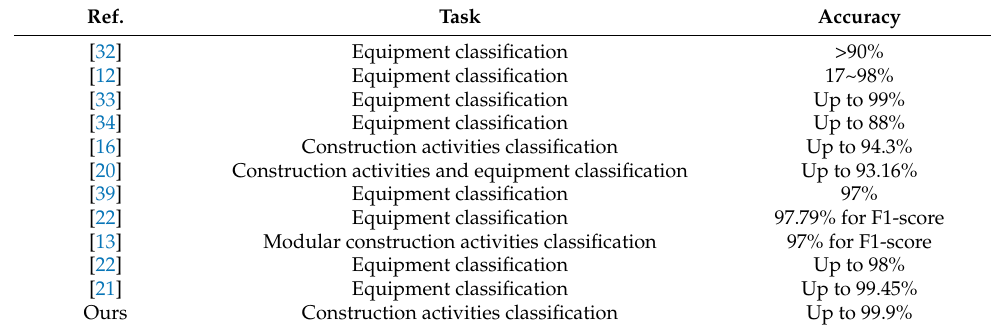
Table 4. The performance of our method compared with prior studies in multi-class classification